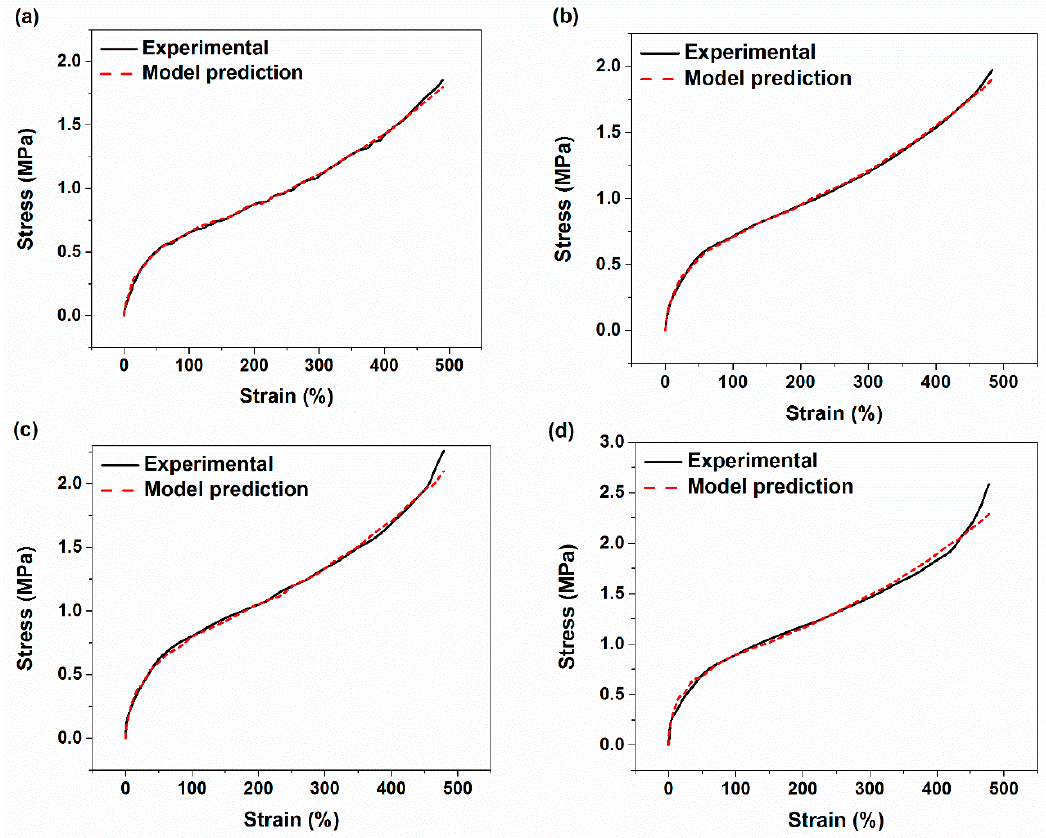
Figure 7. Comparison between the experimental values and model prediction on uniaxial tensile behavior for various XNBR / epoxy / XHNTs nanocomposites ( a ) XE15 ( b ) XE15H3 ( c ) XE15H5 ( d ) XE15H7.